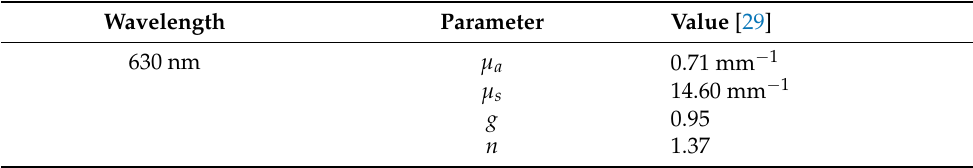
Table 1. Numerical values for the optical parameters of rat liver at 630